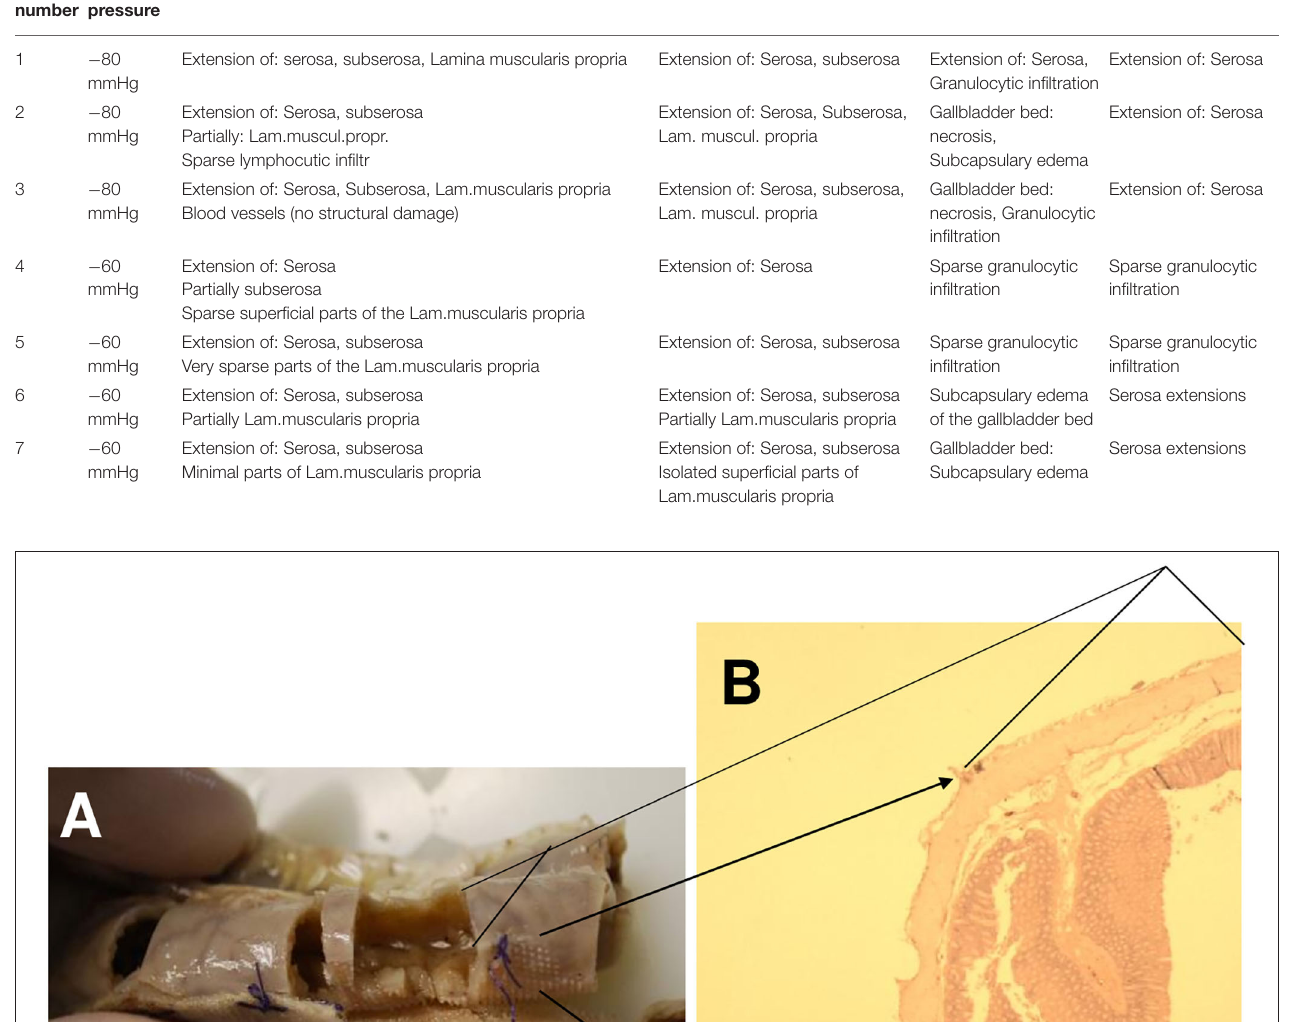
The pads were cut out with the attached parts of the intestine. The anastomotic area of the small intestine and the colon showed no sign of damage or leakage, and no fistula formation.